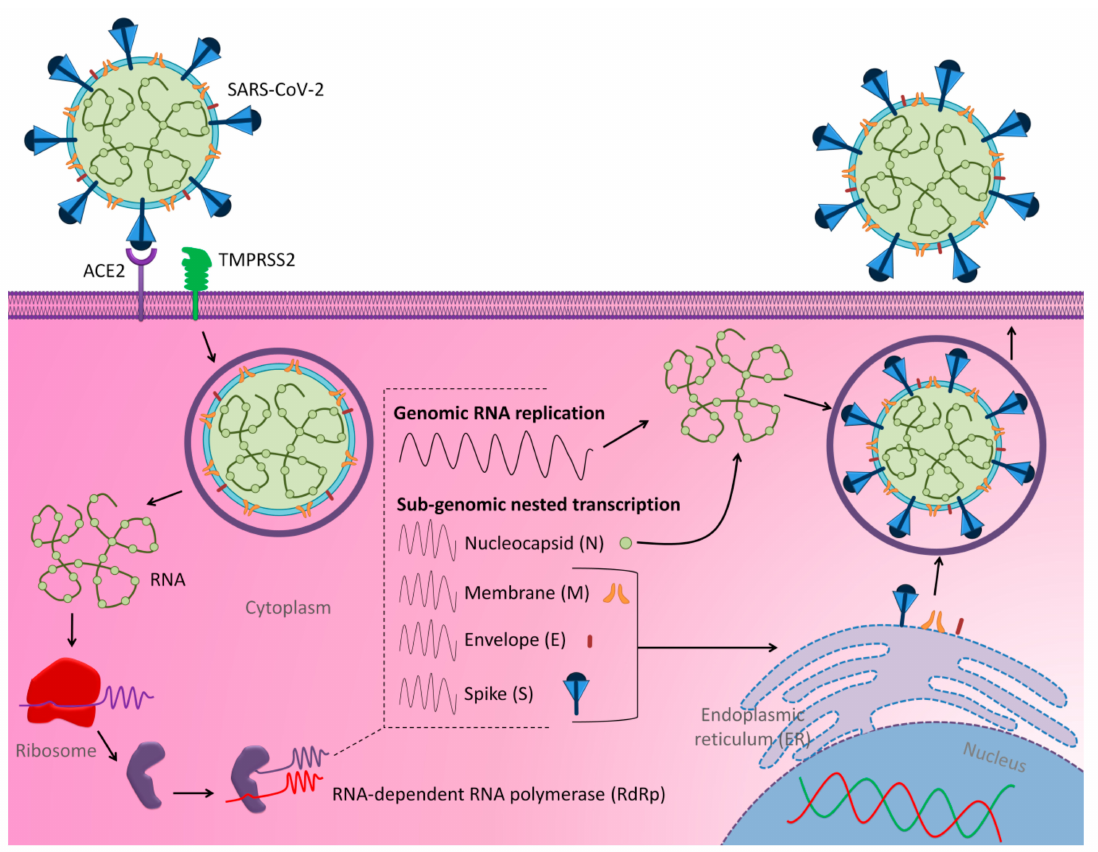
Figure 1. The schematic mechanism of replication of SARS-CoV-2 into host cell. Spike (S) protein on the surface of severe acute respiratory syndrome coronavirus-2 (SARS-CoV-2) recognizes the ACE2 receptor on the cellular membrane of host cell. After receptor binding, the virus enters host cell cytosol via cleavage of S protein by transmembrane protease / serine subfamily member 2 (TMPRSS2), followed by fusion of the viral and cellular membranes. The conformational changes at the S1 and S2 subunits facilitate the virus–cell fusion via the endosomal pathway. The viral genome is released into the cytoplasm and translated through the ribosomal frame, shifting to generate replicas polyproteins pp1a and pp1b. Negative-sense RNA intermediates are generated to serve as the templates for the synthesis of positive-sense genomic RNA (gRNA) and sub-genomic RNAs (sgRNAs). The gRNA is packaged by the structural proteins to assemble progeny virions. Shorter sgRNAs encode conserved structural and accessory proteins. Following gRNA and sgRNA synthesis, the viral proteins and genome RNA are inserted into virions and assembled in the ER-Golgi intermediate compartment (ERGIC) and then transported in the vesicle to the plasma membrane before releasing out via exocytosis pathway